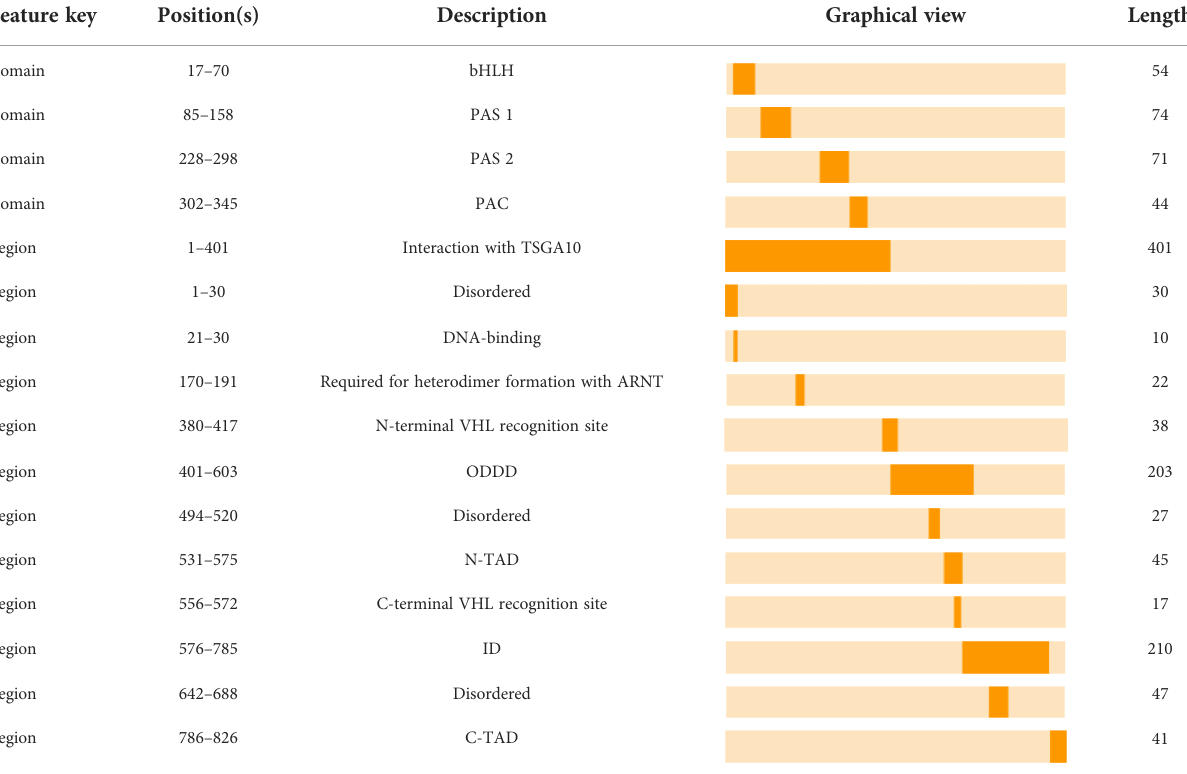
TABLE 2 The Location of the HIF-1 Partial Functional